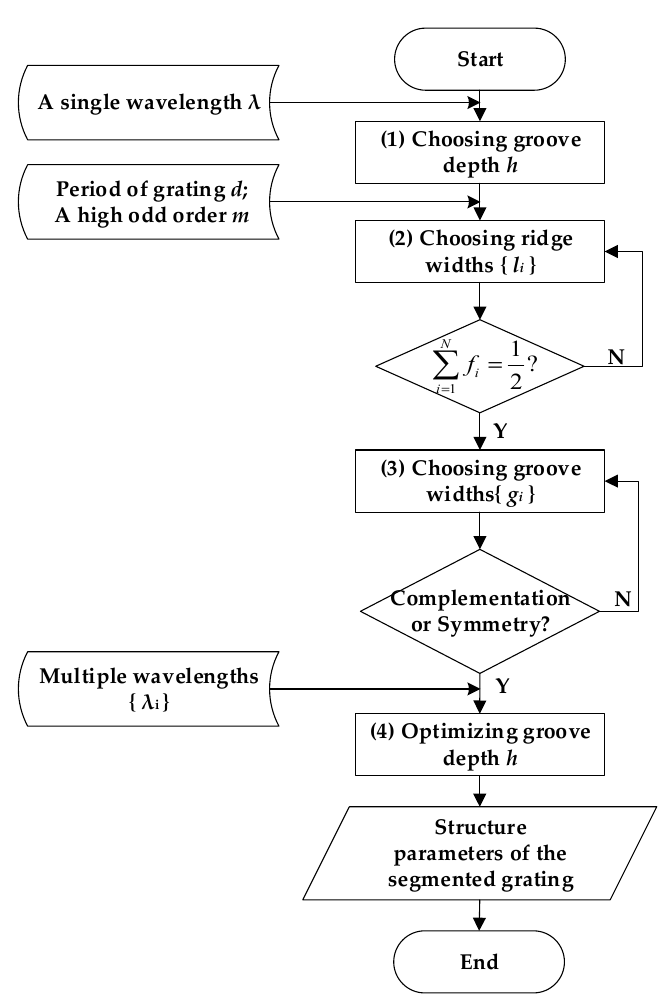
Figure 13. Flow chart of design method of segmented